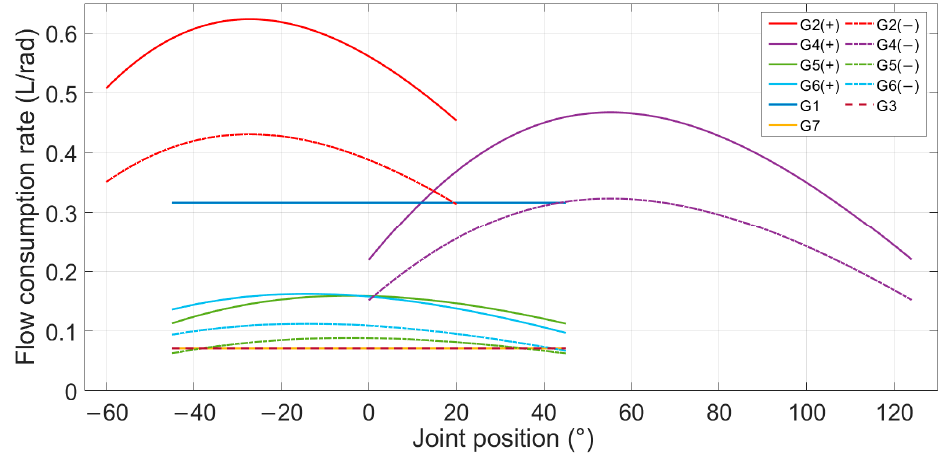
Figure 4. Flow consumption rate (FCR) varies with the change of joint position and motion direc- tion.